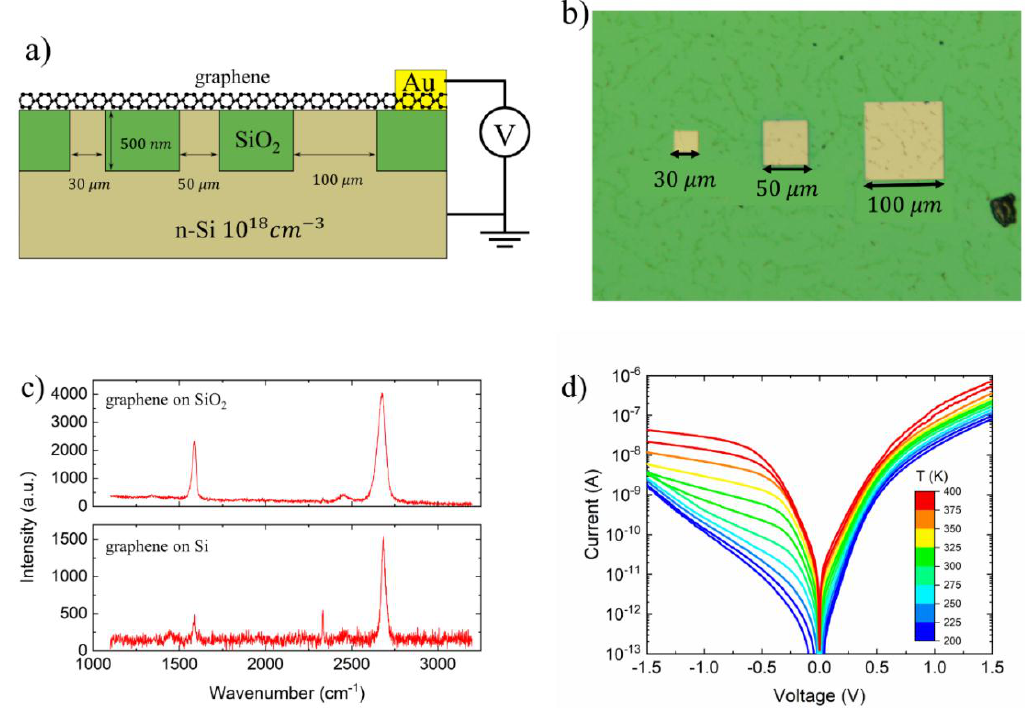
Figure 1. ( a ) Two-dimensional (2D) schematic view of the gr / Si-pillar device. ( b ) Optical microscope image of the pillars. ( c ) Raman spectroscopy of the graphene on SiO 2 and Si. ( d ) The current-voltage (I-V) characteristic of the device measured from 200 K to 400 K .